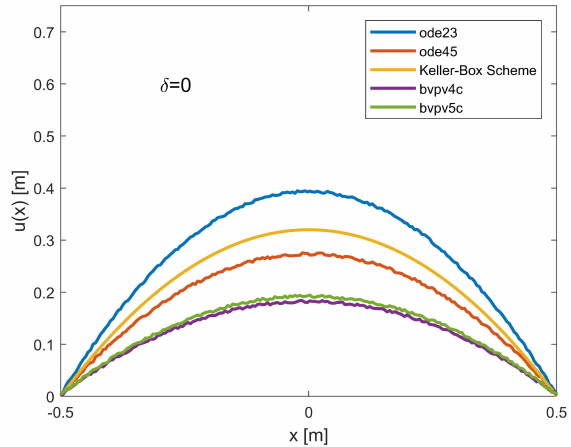
Figure 5. Profile recovery for δ = 0 (in the absence of a fringing field, in convergence conditions, and without ghost solutions).